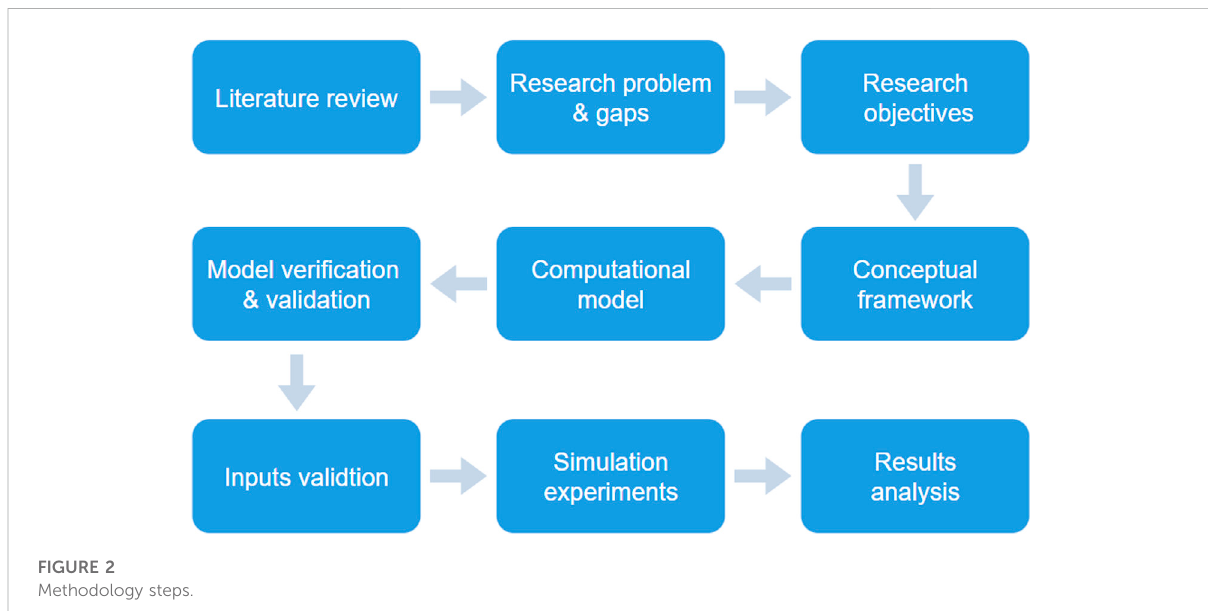
FIGURE 2 Methodology